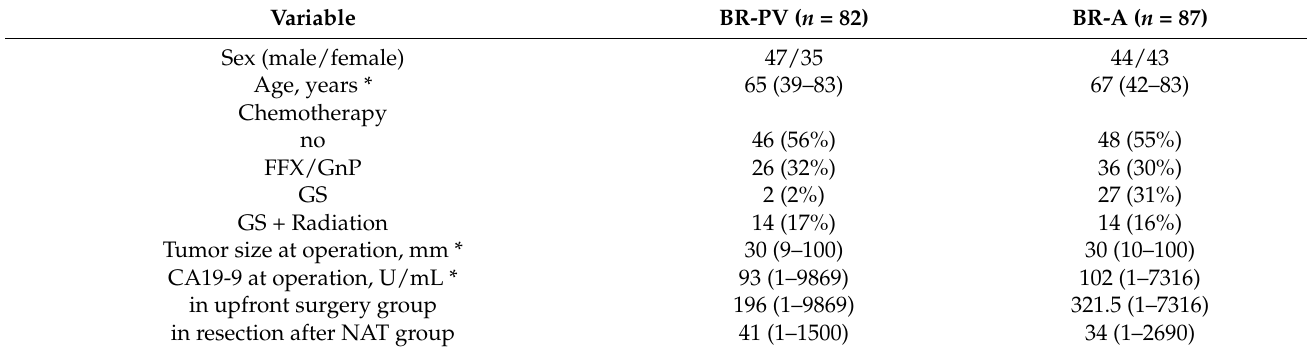
Table 2. Baseline characteristics of patients with BR-PDAC who underwent